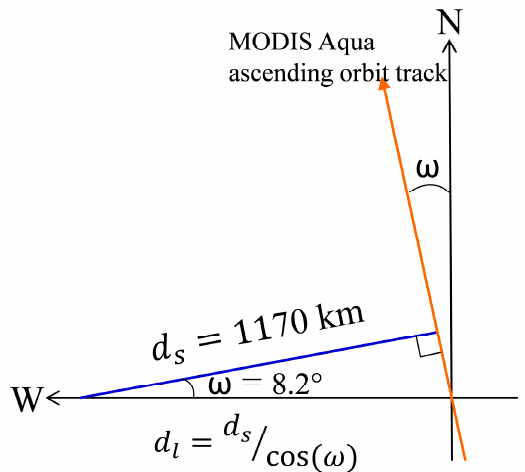
Figure A1. Illustration of calculating the projected length of a MODIS swath along the cycle of latitude. The orange arrow represents between the ascending orbit track of MODIS Aqua and the blue line shows a cross-track half of MODIS swath.